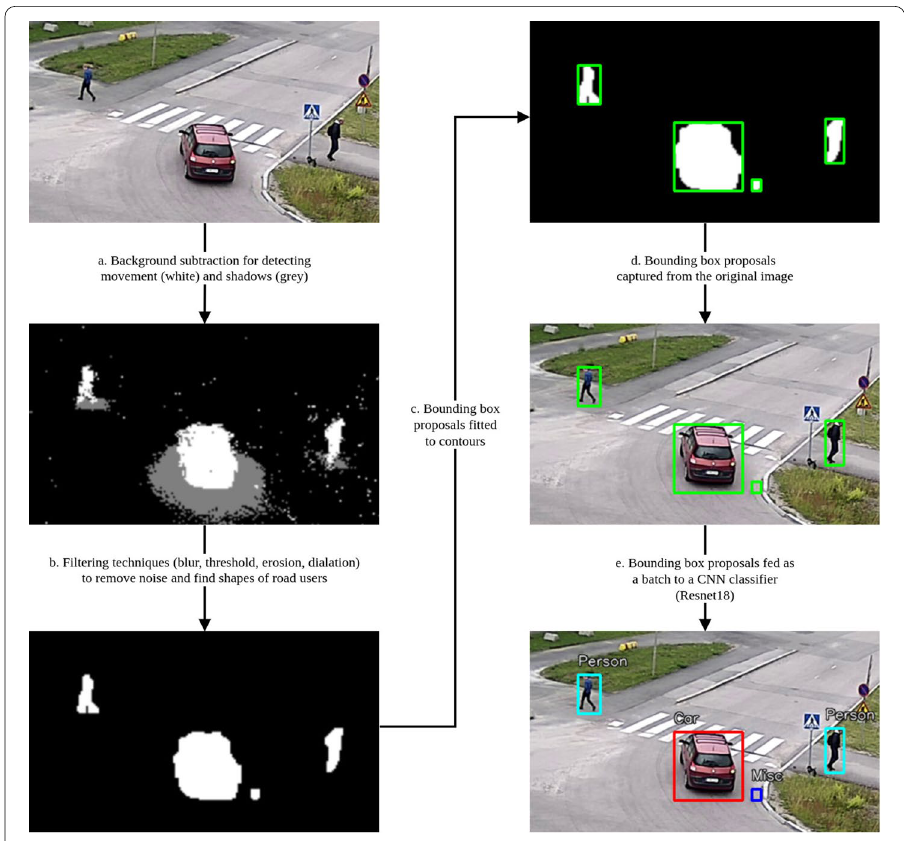
Fig. 1 MoDeCla workflow summarised